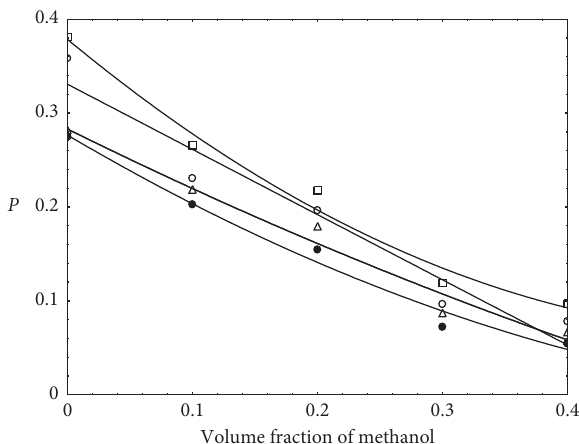
Figure 9: Variation in P with the volume fraction of methanol: squares (298.15K), circles (308.15K), triangles (318.15 K), and closed circles (323.15K).